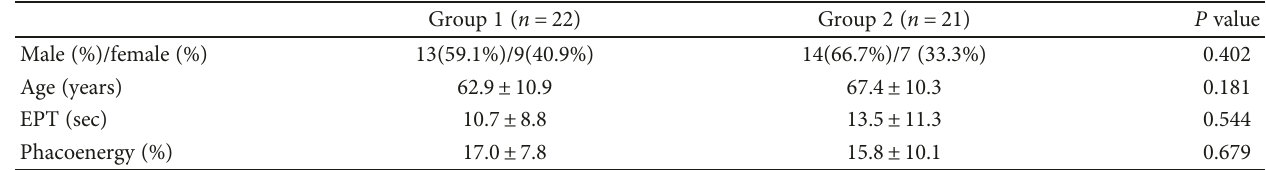
Table 1: Demographical data of patients.